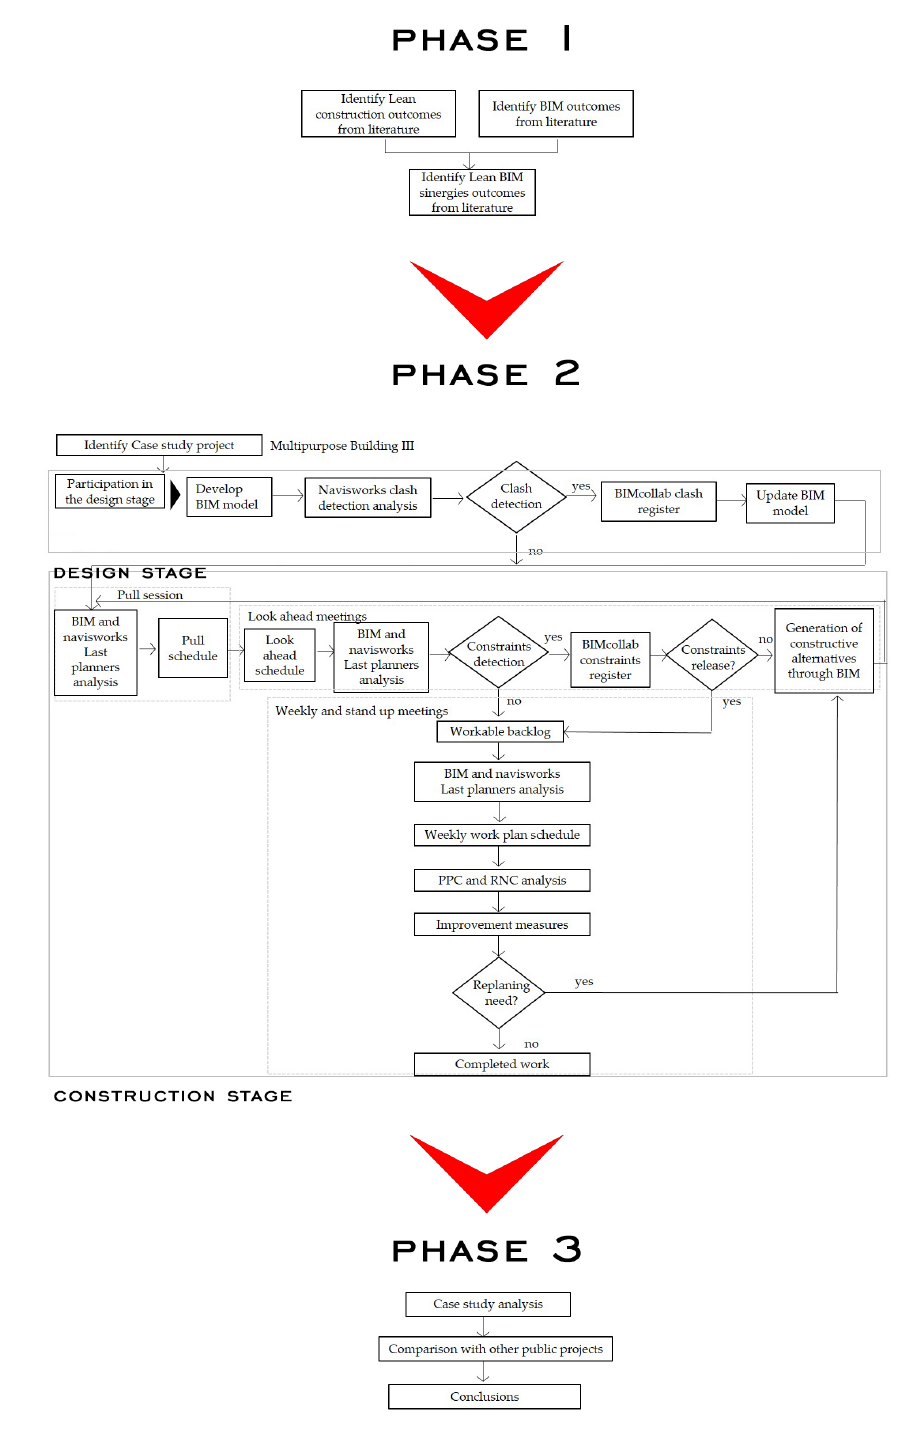
Figure 3. Overall research